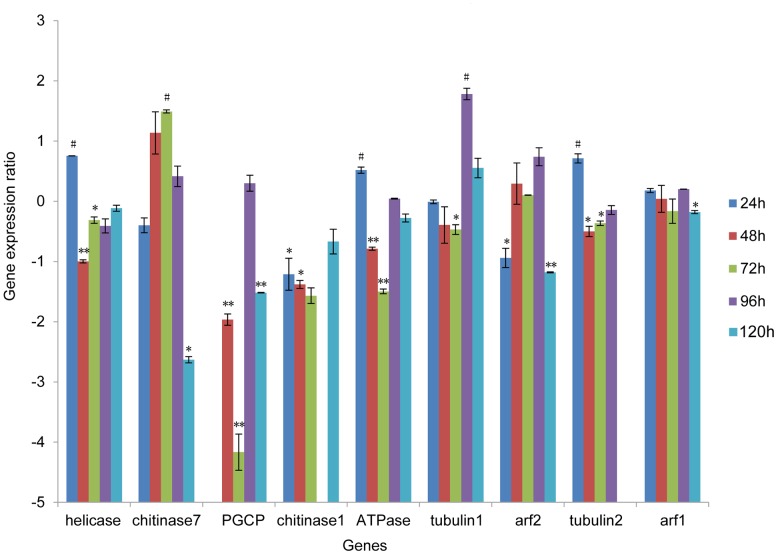
Relative mRNA abundance of nine target genes after injecting siRNAs.The mRNA levels of target genes were monitored by qRT-PCR at 24, 48, 72, 96 and 120 h after injection. Three insects were collected for each time point. The data for PGCP at 24 h, chitinase 1 at 96 h, and tubulin2 at 120 h are absent because of the unsuccessful RNA purification. Larvae injected with siRNA with a random sequence were used as negative controls. Two housekeeping genes, G3PDH and E2F, were used as multiple internal controls. The qRT-PCR data were analyzed using the delta-delta Ct method. The mRNA abundance of target genes in the negative control was used as the calibrator sample. The mRNA levels of target genes in the siRNA-treated group were relative to the negative control group at the same time point. Error bars indicate standard errors. Statistical significance of differences were analyzed with student T-test (decreasing significance,* P<0.05, **P<0.01; increasing significance, # P<0.05 ).